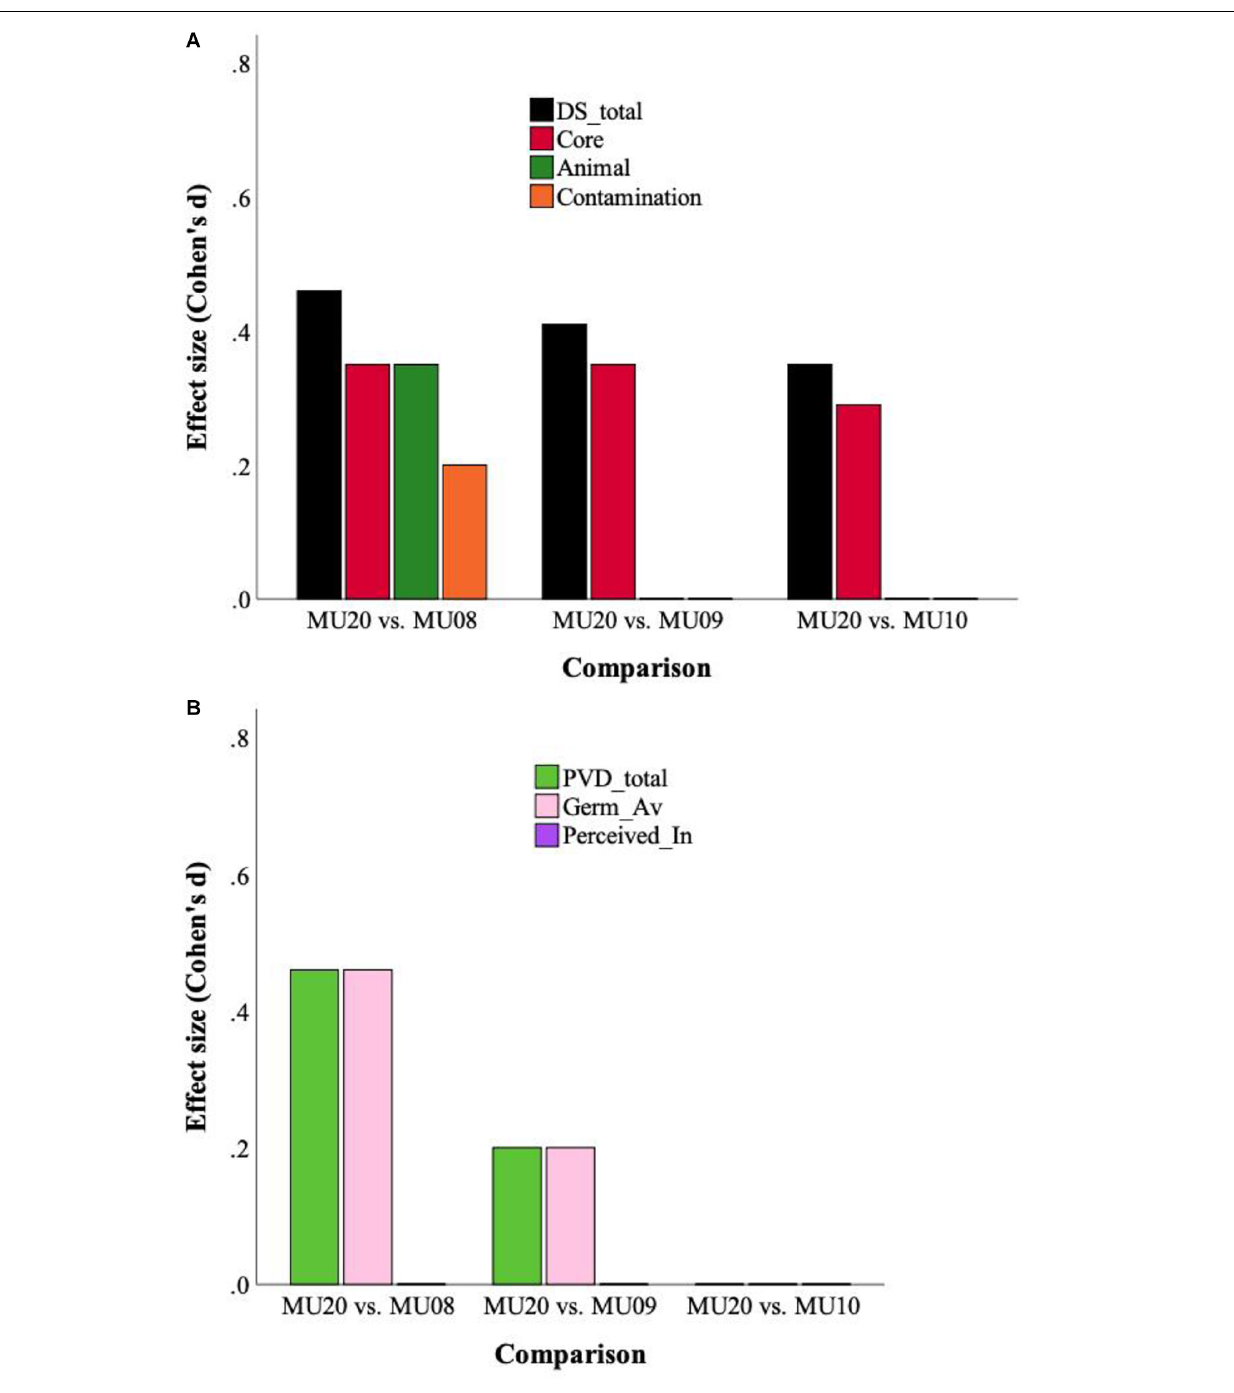
The two different sets of analyses are presented in Table 5 . The raw data analyses, using MANCOVA (Sample, Gender; Age as covariate) with the three subscales as dependent variables, revealed significant effects of Sample